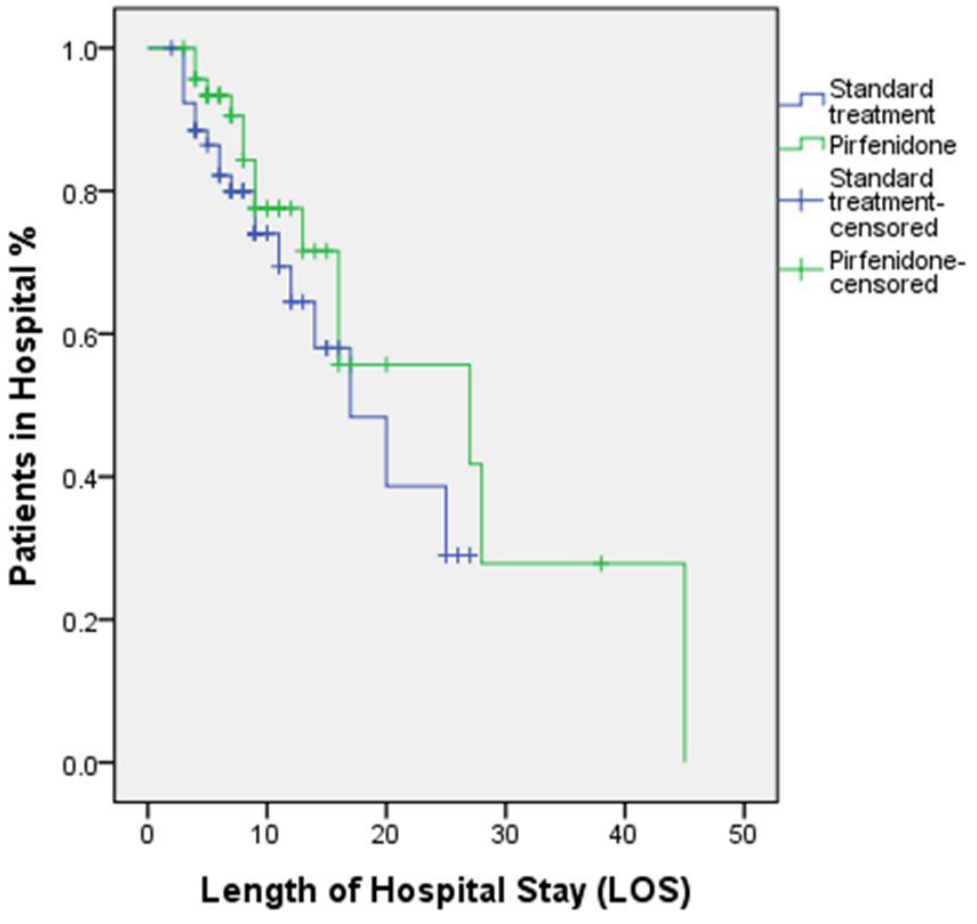
Figure 3. Kaplan – Meier curves and log-rank test show the time needed to discharge from hospital p p = = 0.256.